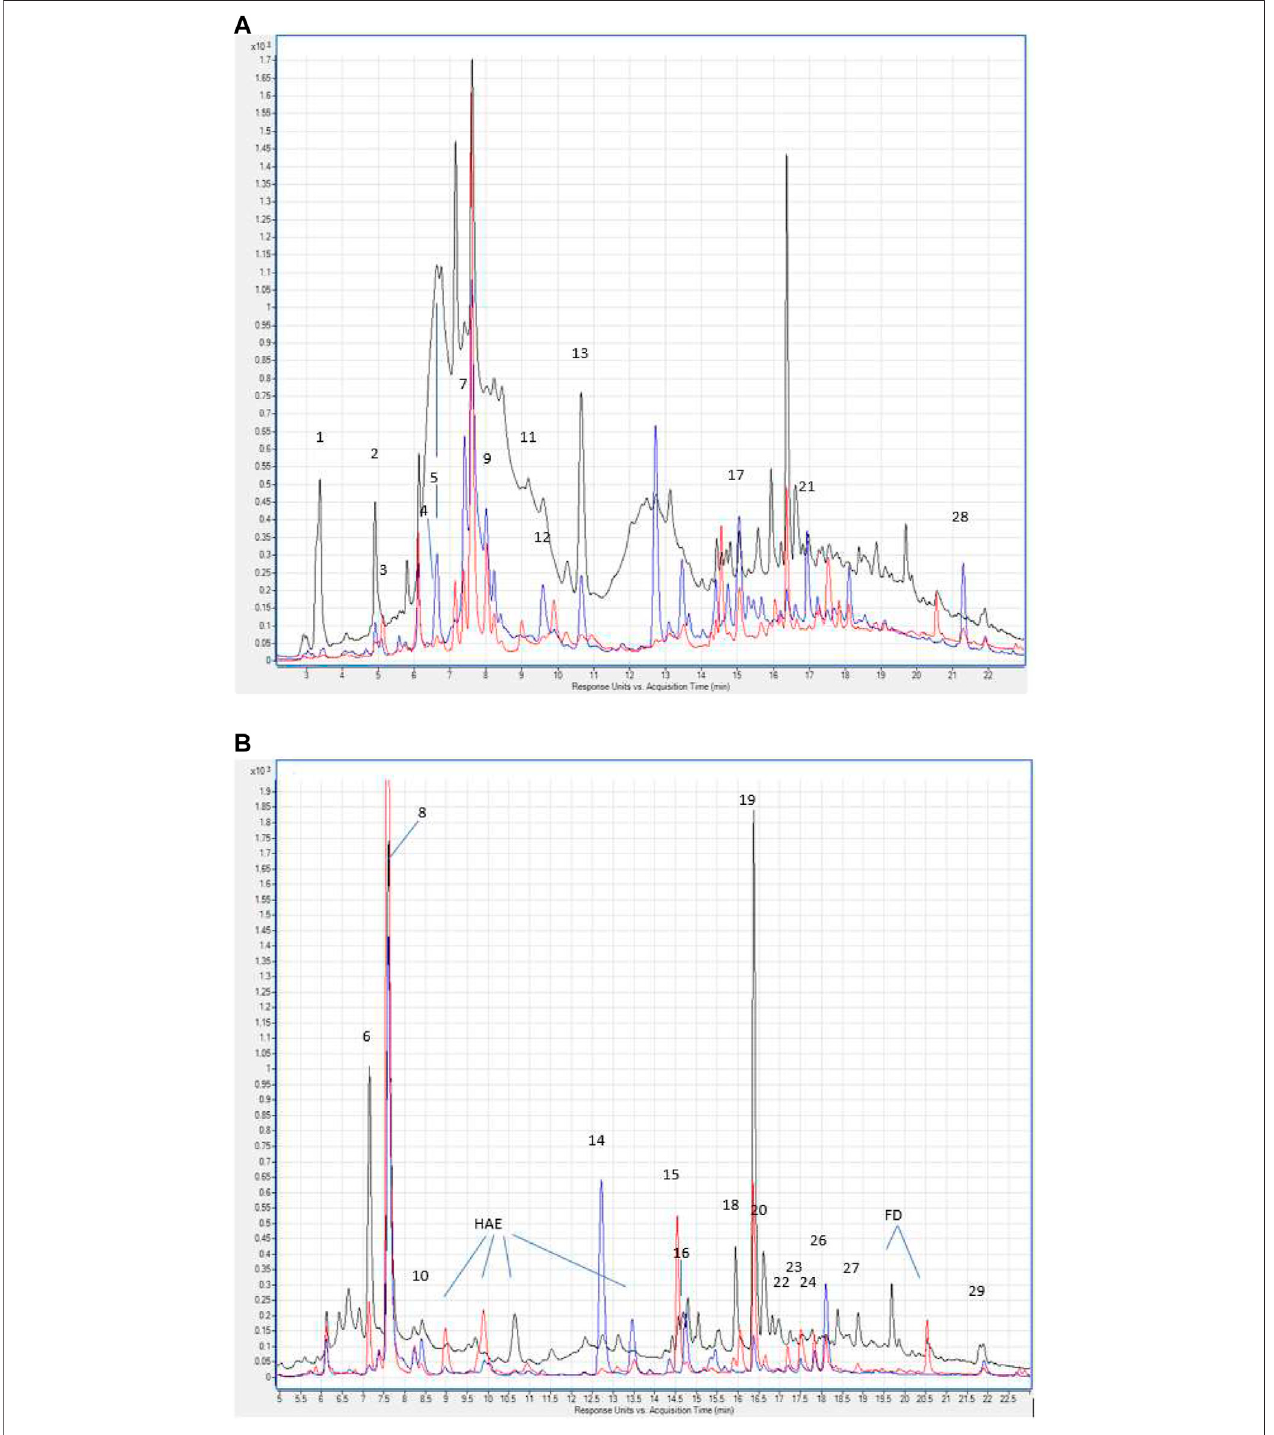
FIGURE1|(A) Hydroxybenzoic acids and fl avan-3-ols in thechromatograms of Allium nutans L. honey (redline), Helianthus annuusL. honey (blueline) extracts. λ 280 nm. Numbering corresponds to Table 1 . Hydroxycinnamic acids and fl avonols in the chromatograms of extracts Allium nutans L. (red line), Helianthus annuus L. (blue line). λ 325 nm. The numbering corresponds to Table 1 . HAE - hydroxycinnamic acid esters. FD - fl avonol derivatives.